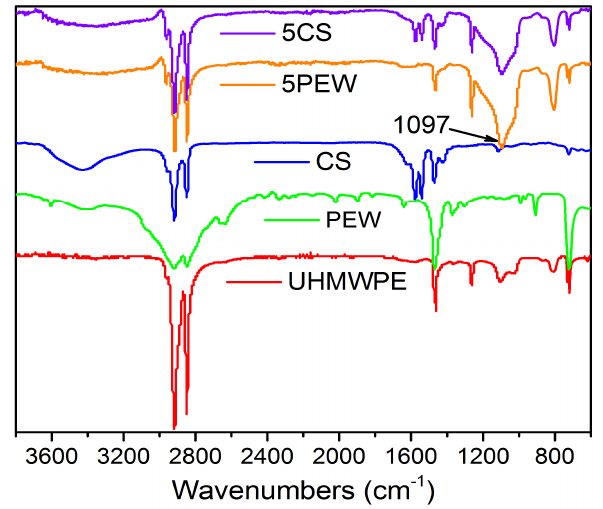
Figure 2. FTIR spectra of UHMWPE, PEW, CS, 5PW, and 5CS.